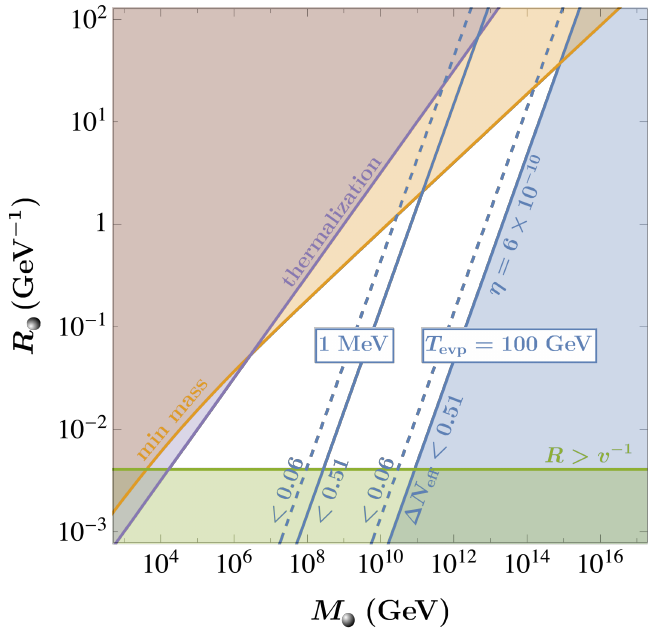
Figure 3 . Same as figure 2, but now allowing an asymmetric component of EWS balls that eventually decay into massless states in the dark sector. Constraints from ∆ N eff limit where baryogenesis can produce large enough η . Examples for present (projected) constraints are shown in solid (dashed) blue lines for two different possible evaporation temperatures. Because T evp < T EWPT ∼ 100 GeV is required for baryogenesis by EWS balls, the shaded blue region on the right is completely excluded by current constraints. If the dark sector states are massive, additional constraints can apply as discussed in the